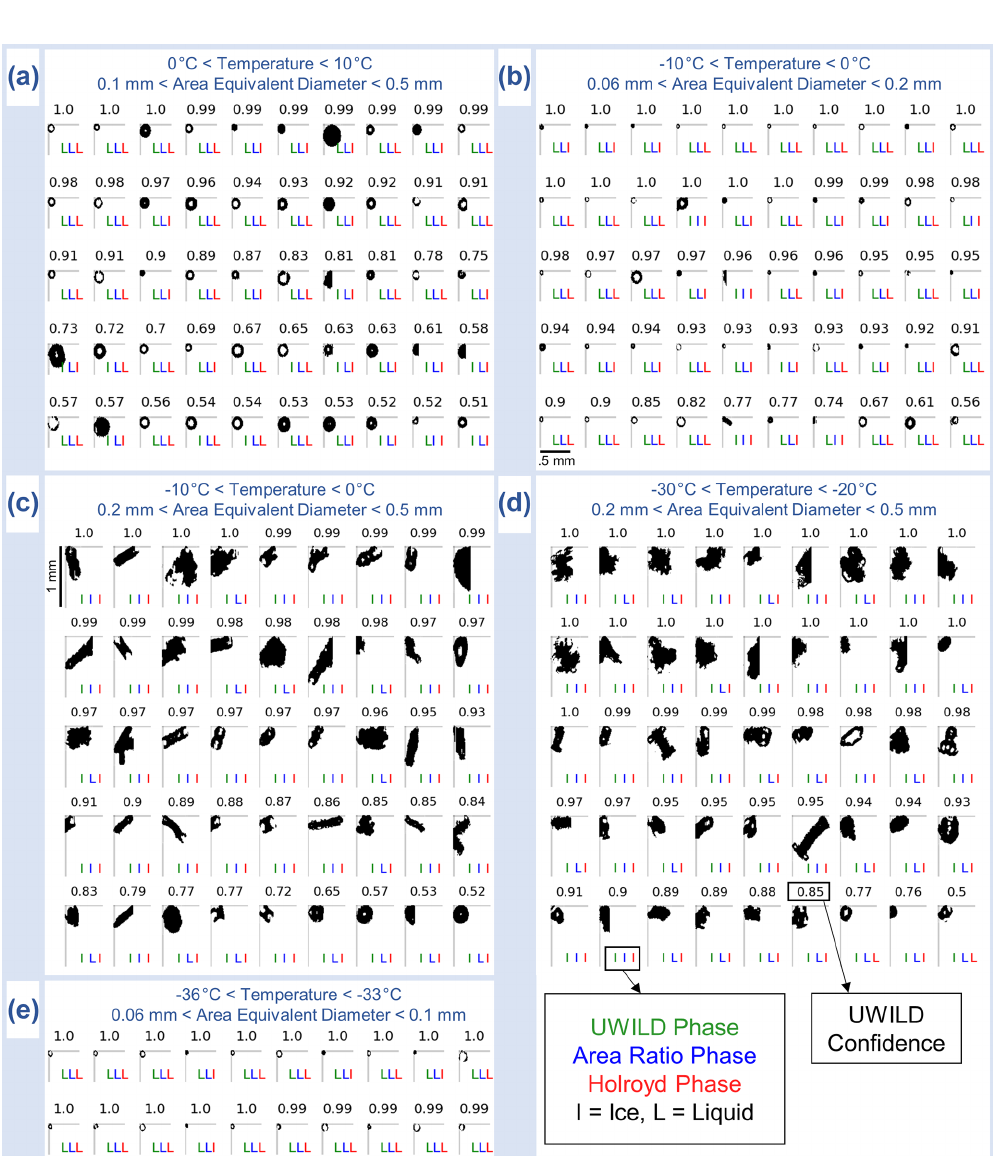
Figure 9. Randomly sampled images are shown for the five regions overlaid on the temperature–particle-size phase space in Fig. 8. UWILD confidence is displayed above each particle, and, from left to right, UWILD phase (green), area ratio phase (blue), and Holroyd phase (red) are displayed below each particle. The time dimension is vertical, and the photodiode dimension is